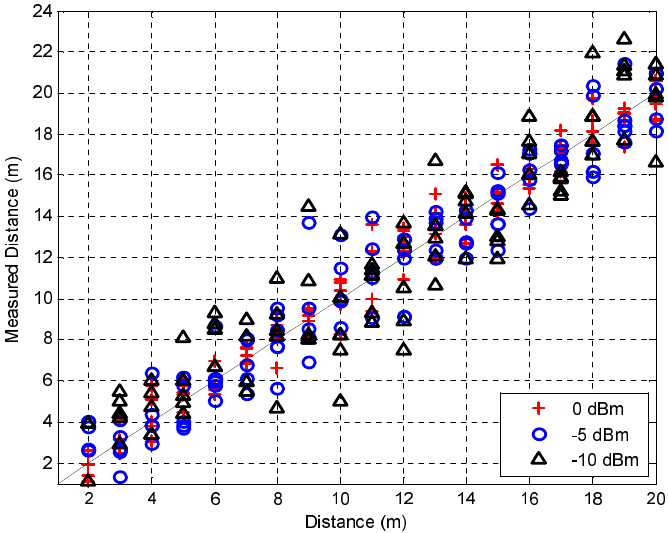
Figure 13. Measured distance for various transmit